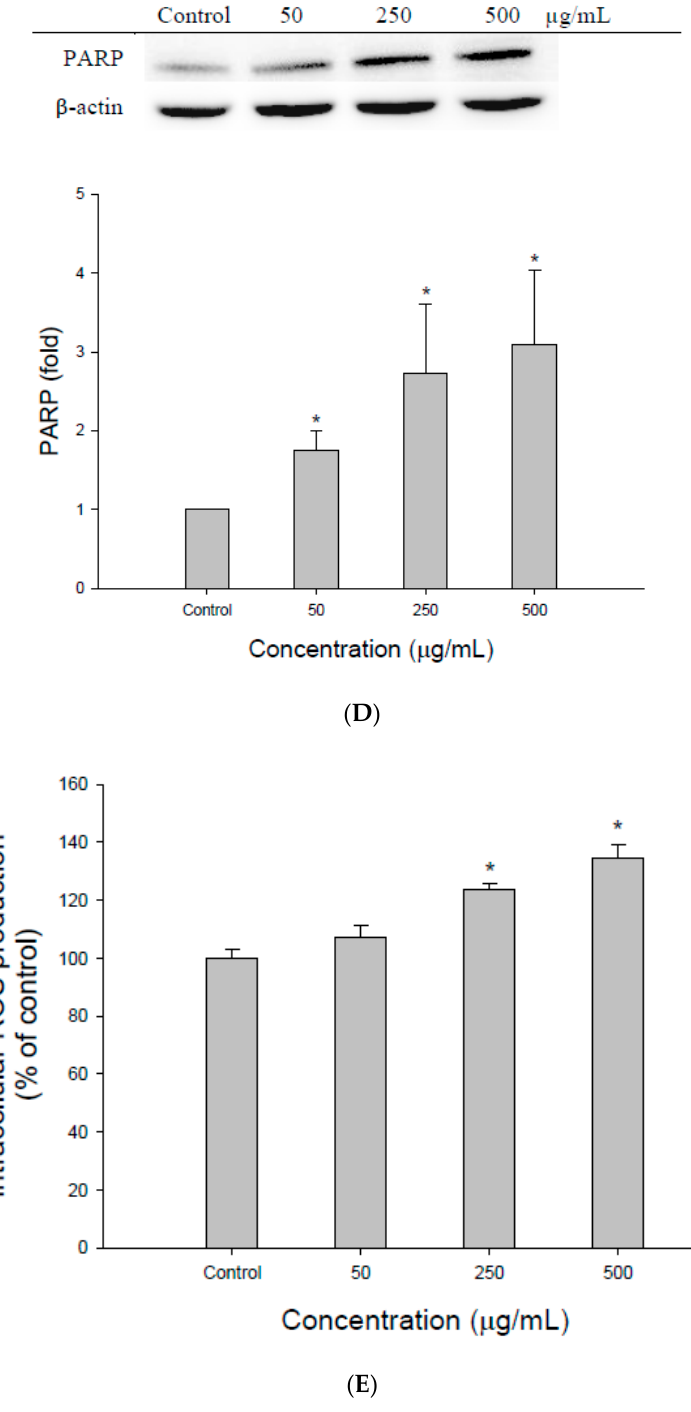
Figure 2. The effect of different concentrations of ethanolic extracts of djulis husk (EEDH) on HepG2 cells apoptosis. ( A ) Effect of EEDH on mitochondrial membrane potential in HepG2 cells. ( B ) Effect of EEDH on Bax/Bcl-2 ratio in HepG2 cells. ( C ) Effect of EEDH on caspase-3 activity in HepG2 cells. ( D ) Effect of EEDH on PARP cleavage in HepG2 cells. ( E ) Effect of EEDH on reactive oxygen species (ROS). The cells were incubated with EEDH for 24 h ( A ), 24 h ( B ), 48 h ( C ), 56 h ( D ), and 16 h ( E ), respectively. The data are expressed as the mean ± SD ( n = 3). * indicated significant difference from the control ( p < 0.05).